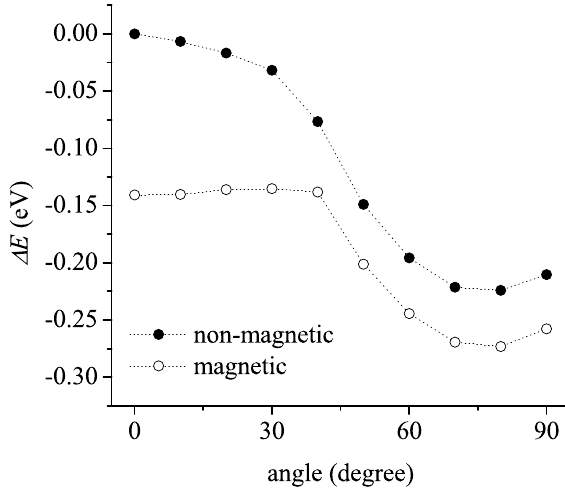
Figure 2. Total energy variation with dihedral angle. Filled circles are for non-magnetic results while open circles are for spin-polarized results. ∆ E is defined as the difference from the non-magnetic energy at 0 ◦